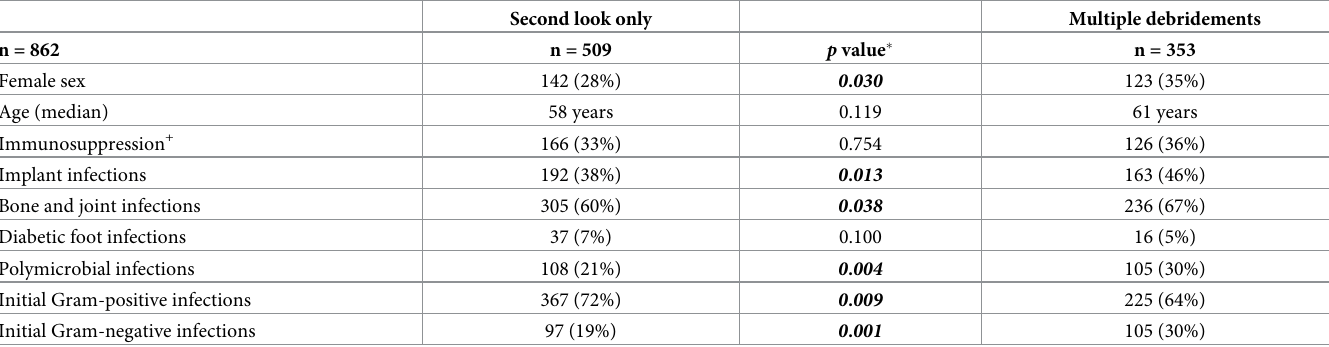
Table 1. Demographic and clinical variables comparing the second look to multiple debridements ( > 2 lavages). Second look